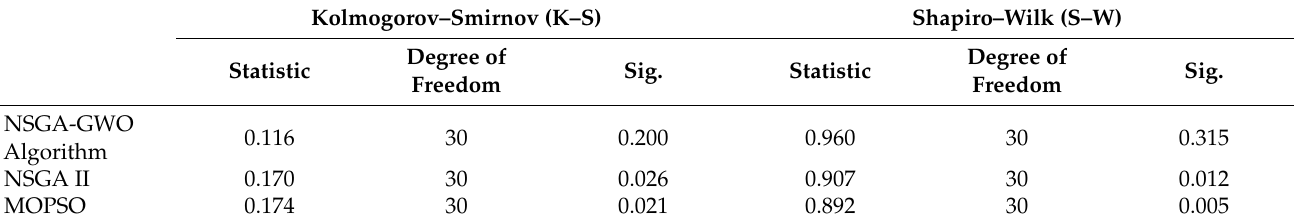
Table 5. Normality test